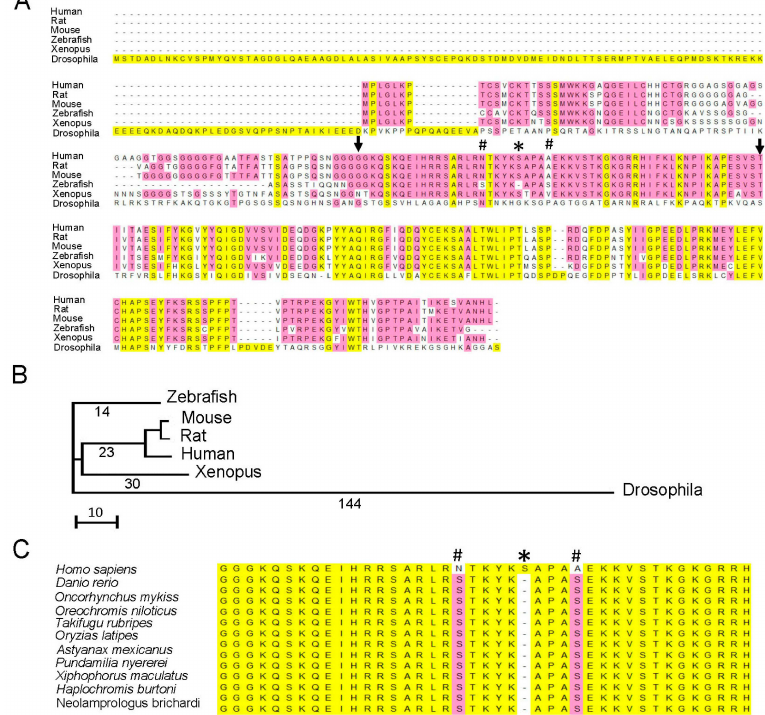
Figure 1. Gatad1 is highly conserved between human and zebrafish. ( A ) Alignment of human GATAD1 protein sequence and five animal species. The human S102P mutation is localized to a region highly conserved in most animal models except Drosophila. Zebrafish does not have a serine residue in the position corresponding to human S102, but it has serine residues in positions corresponding to human N 97 and A106. # Human N 97 and A106; * Human S 102; arrows, range of highly conserved sequence from human G79 to I136; ( B ) The phylogenetic tree generated by comparing Gatad1 protein sequences in human and 5 animal species; ( C ) The alignment of peptide sequences flanking human S102 between human and fish species. All fish species have serine residue in the positions corresponding to human N 97 and A106, but not